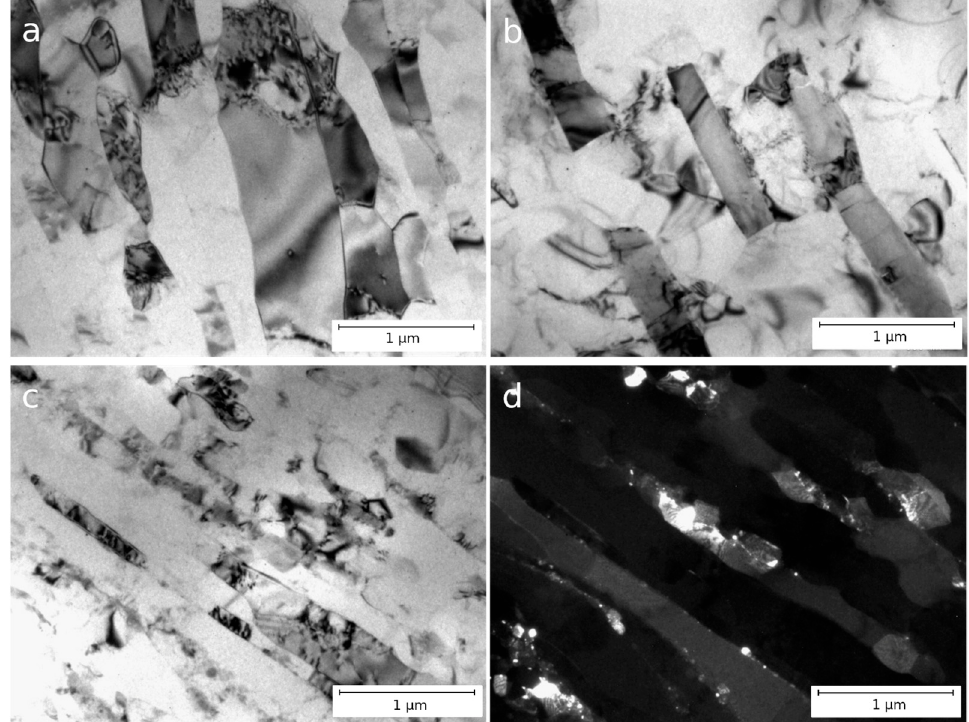
Figure 5. Microstructure of Al–1.7Fe alloys after ECAP and subsequent CR with a reduction ratio of 85%: ( a , b ) CC and ( c , d ) EMC, longitudinal section, TEM.